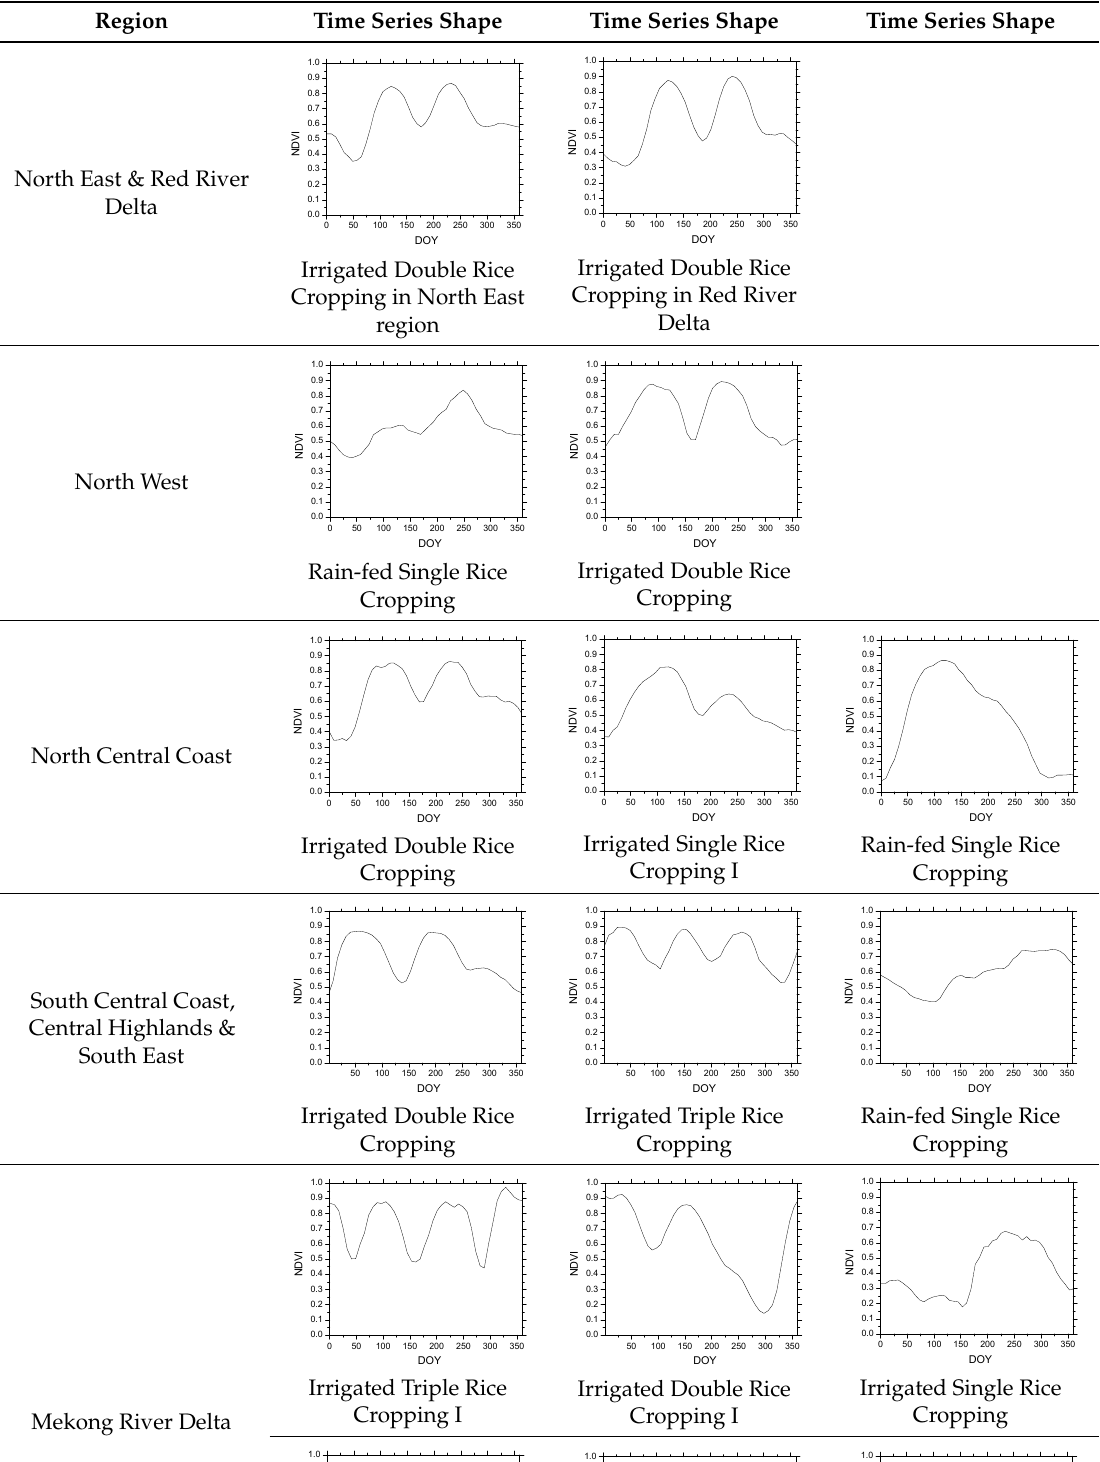
Table 1. Standard rice growing NDVI time series and calculated DTW distance.